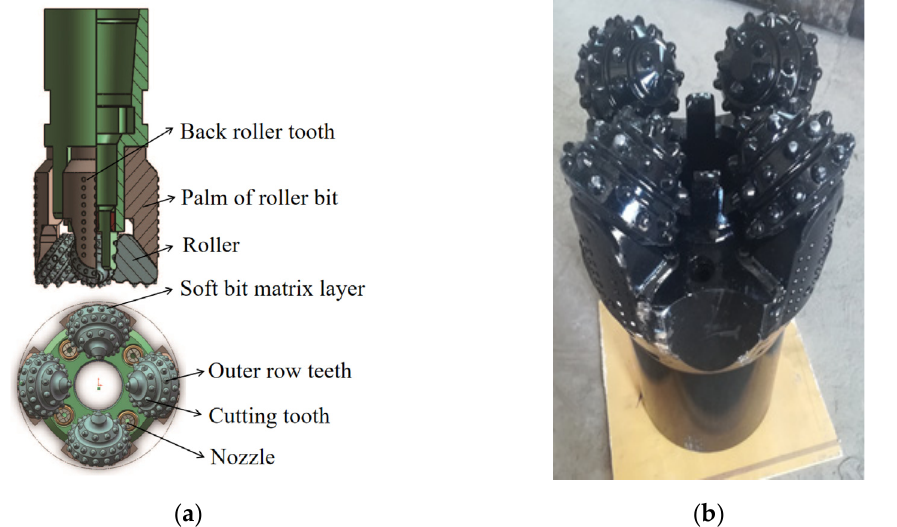
Figure 1. ( a ) Three-dimensional-schematic diagram of roller core bit (scale: 1:3); ( b ) The solid body drawings of roller core